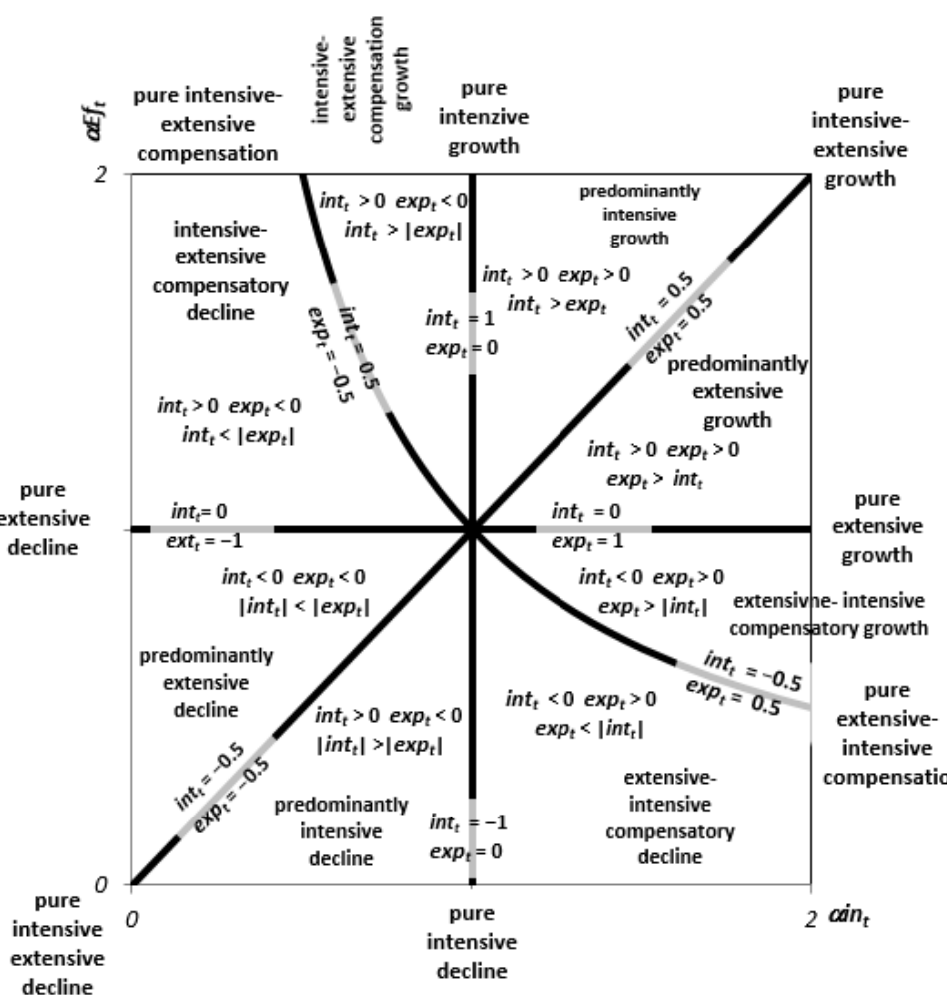
Figure 3. Complex typology of all possible system developments.